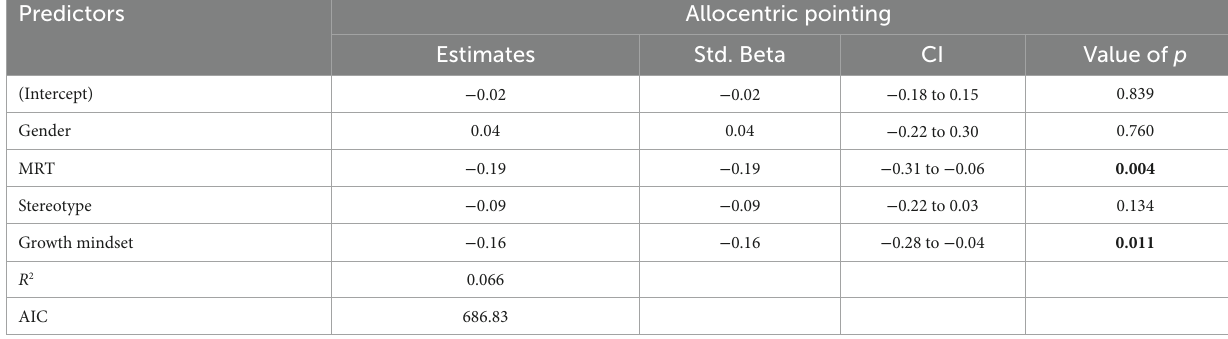
TABLE 3 Results from the best-fitting model for the Allocentric pointing after model selection